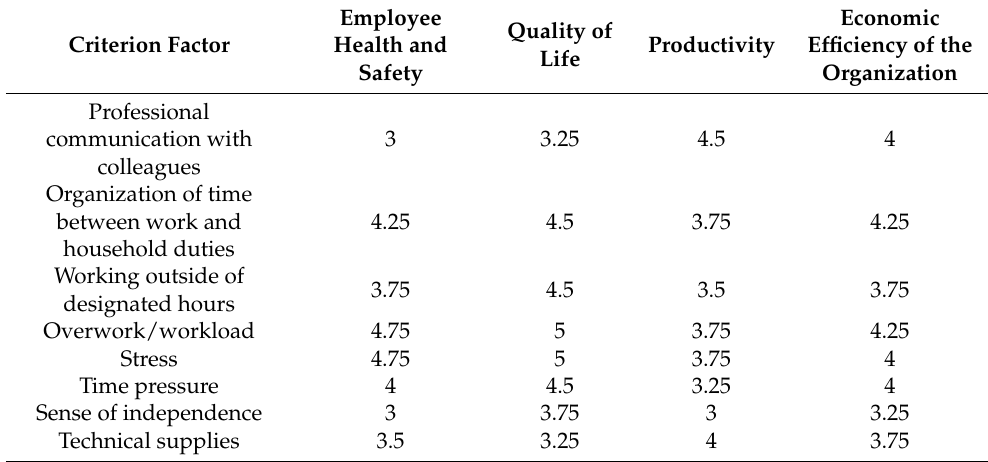
Table 6. Average decision matrix for the Authorities of the Faculty of Management Engineering.